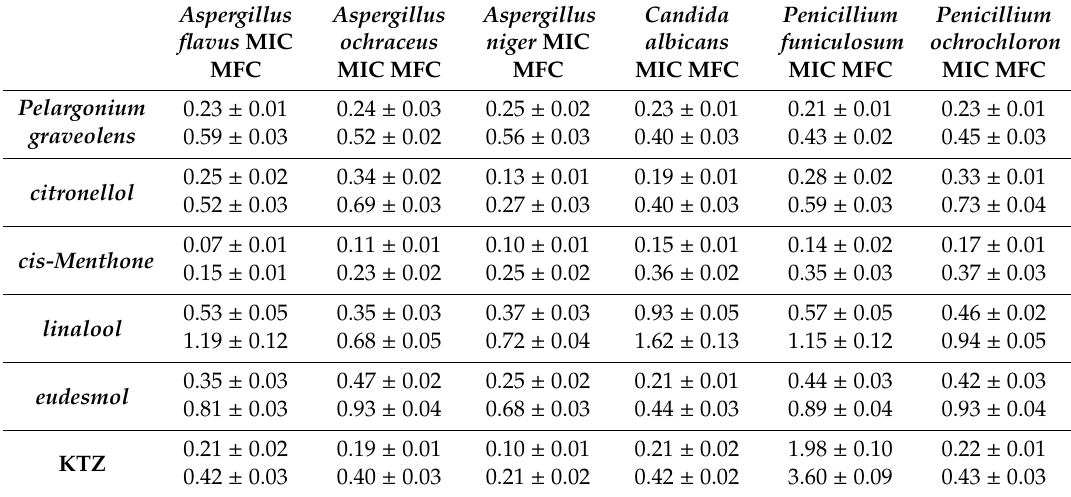
Table 4. Minimum inhibitory (MIC) and fungicidal concentration (MFC) of Pelargonium graveolens leaf extracts (mg mL − 1 ) as well as identified